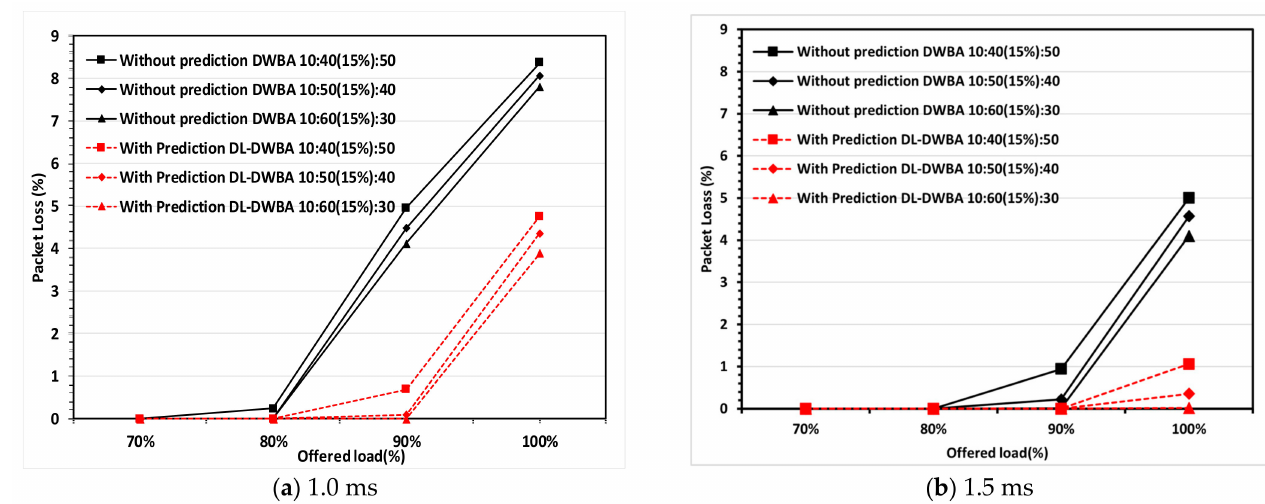
Figure 9. Overall system packet